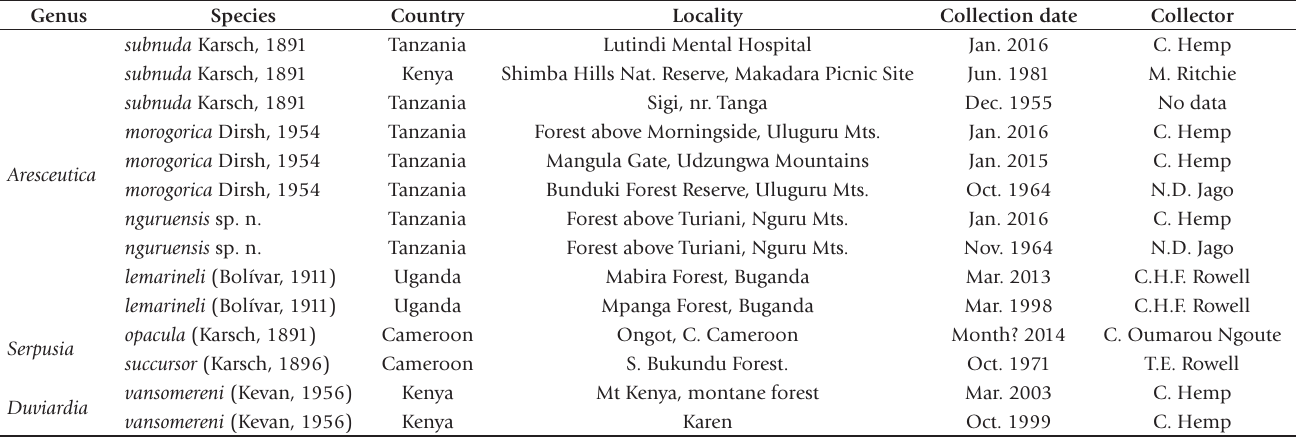
Table 1. Provenances of specimens used for phallic